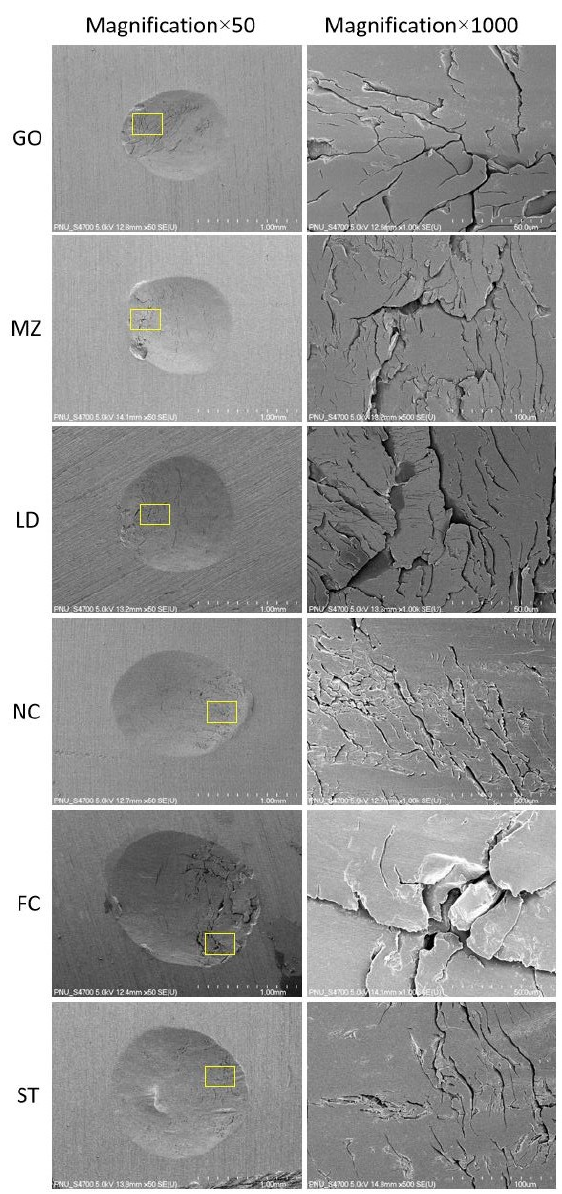
Figure 7. SEM images of the worn surface of the restorative materials. GO, type III gold alloy group; MZ, monolithic zirconia group; LD, lithium disilicate glass ceramic group; NC, Ni–Cr alloy group; FC, feldspathic ceramic group; and ST, steatite group.